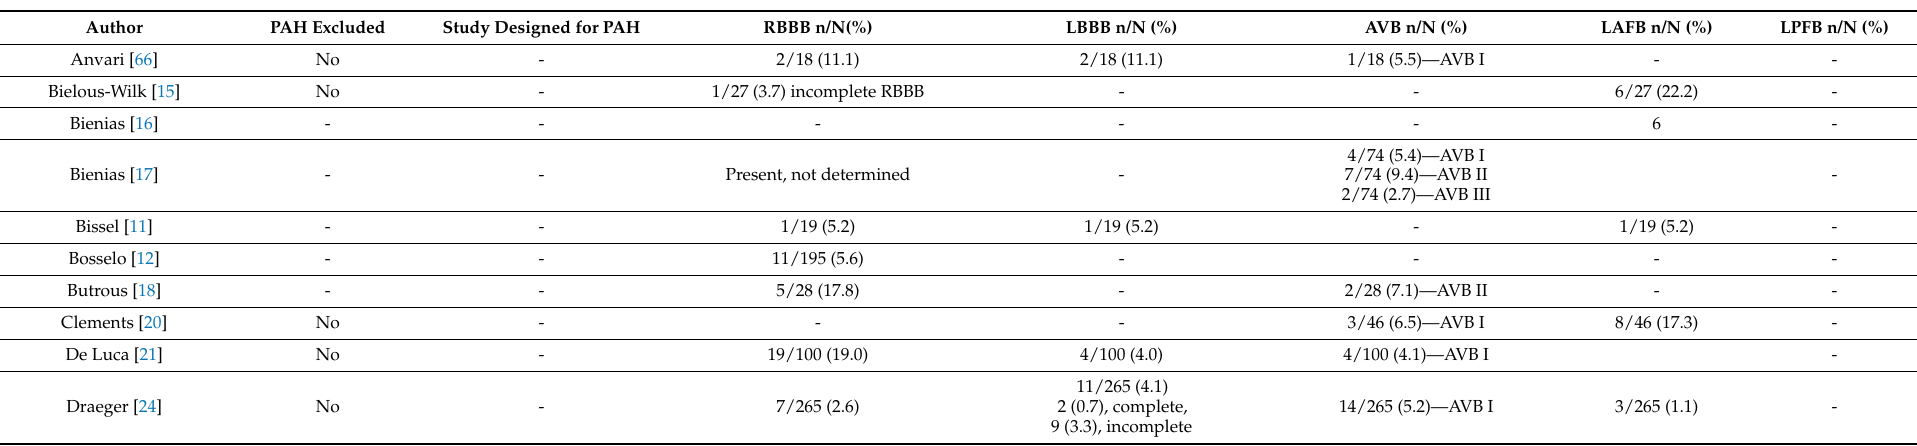
Table 5. Frequency of conduction disturbances in SSc